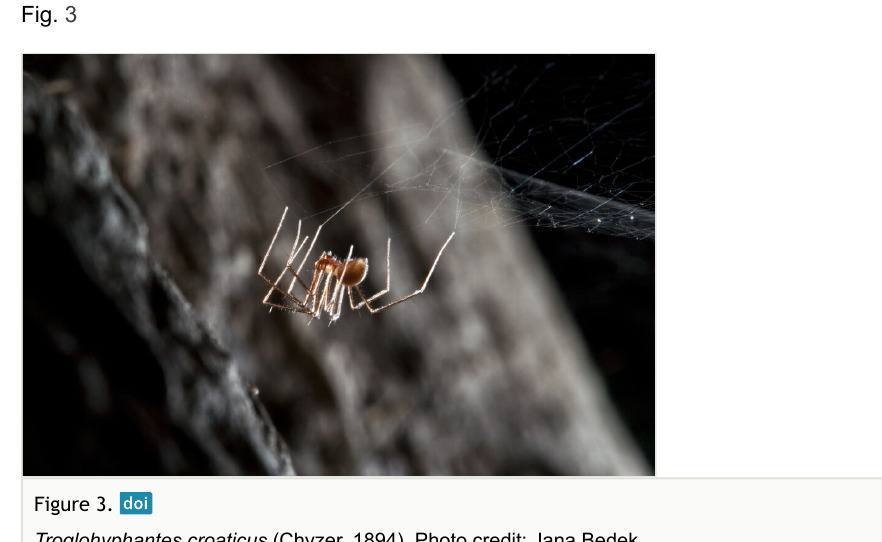
Figure(s) or Photo(s):